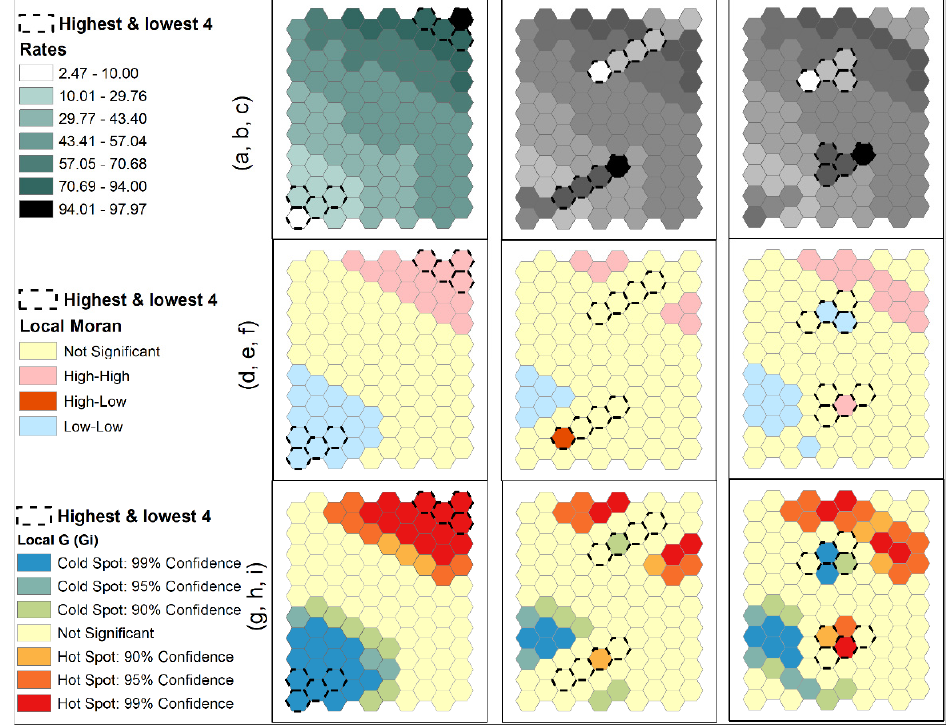
Figure 3. Simulated data for 100-hexagontal tessellation with mean = 50, standard deviation of 18. Three configurations: ( a ) trend surface from lower left to upper right; ( b ) two-strip elongated high and low clusters; ( c ) two compact high and low clusters. Local Moran results ( d – f ) and local G statistics ( g – i ) are shown.